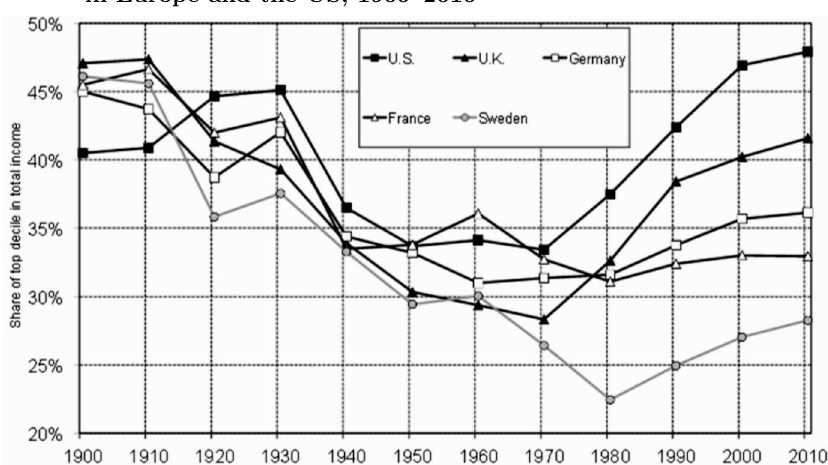
Figure 2. The share of income of the top decile: selected countries in Europe and the US,